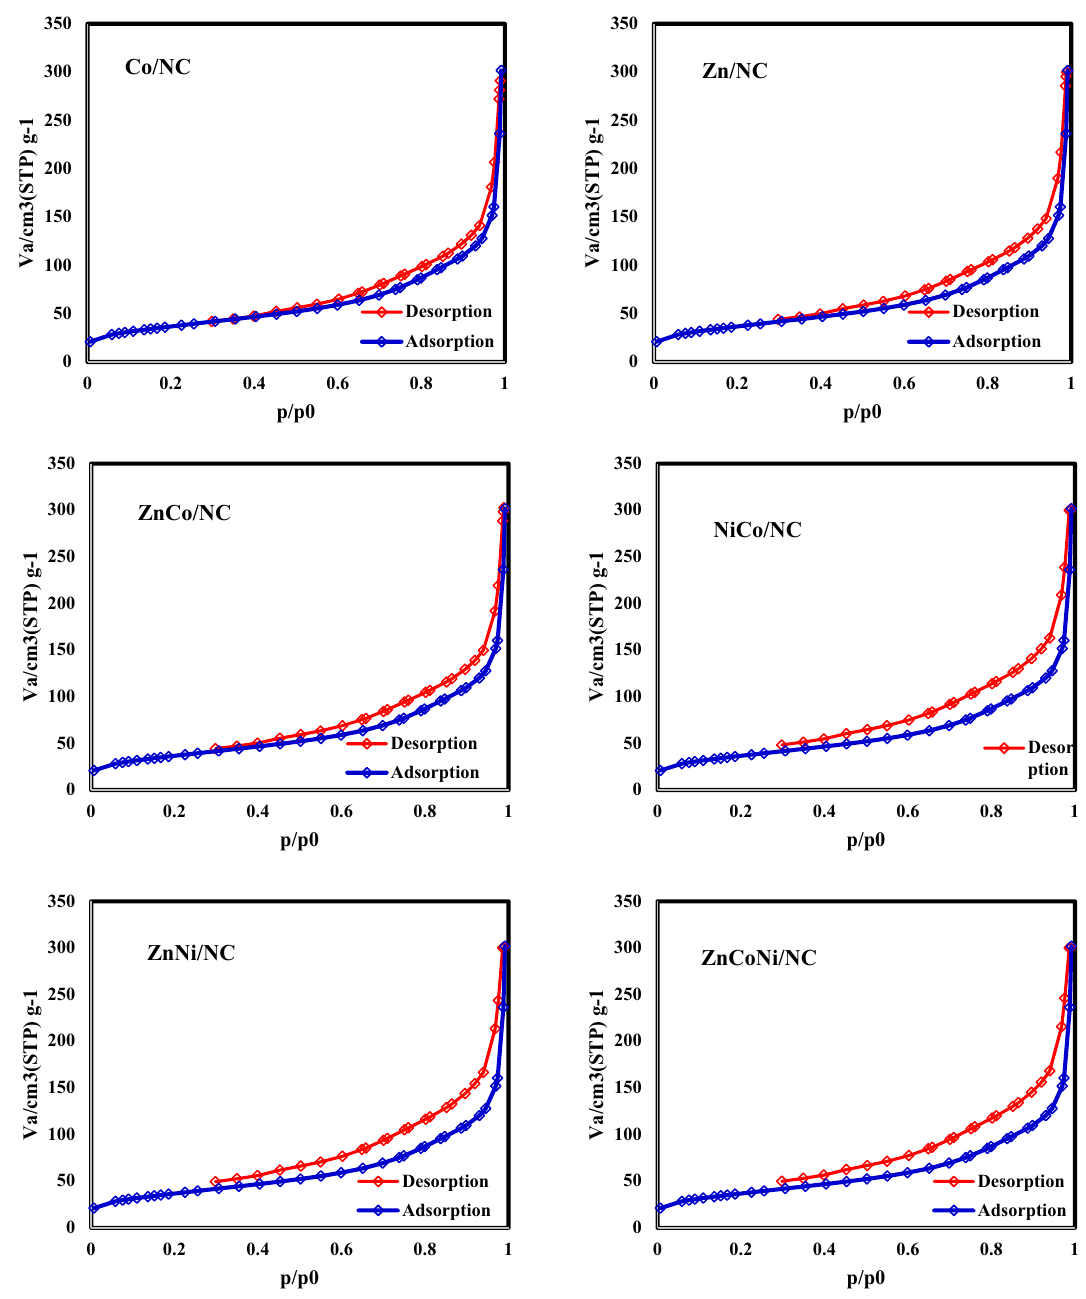
Figure 6. N 2 adsorption/desorption isotherms of samples after carbonization process.